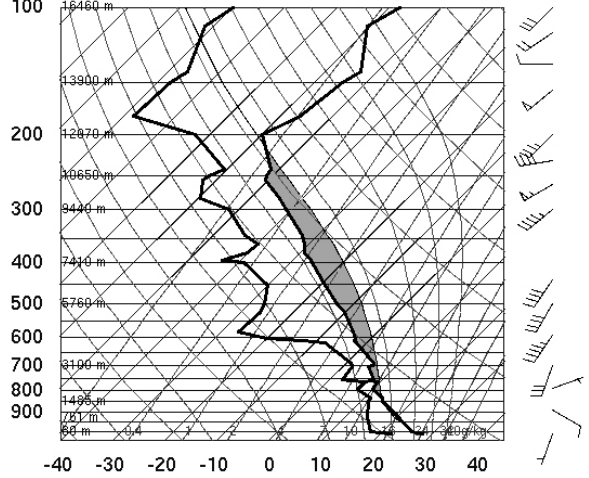
Fig. 7. Skew-T diagram representing the observations measured by the radiosonde launched at Palma de Mallorca at 12:00 UT on 14 September 1999 (provided and calculated by the University of Wyoming). The left thick line is the dew point temperature and the right thick line represents the temperature measurements. The shaded area is the total positive CAPE of an air parcel that is lifted up from the surface. The windbarbs reflect the observed wind di- rection and speed (half line =5kts total line=10kts and